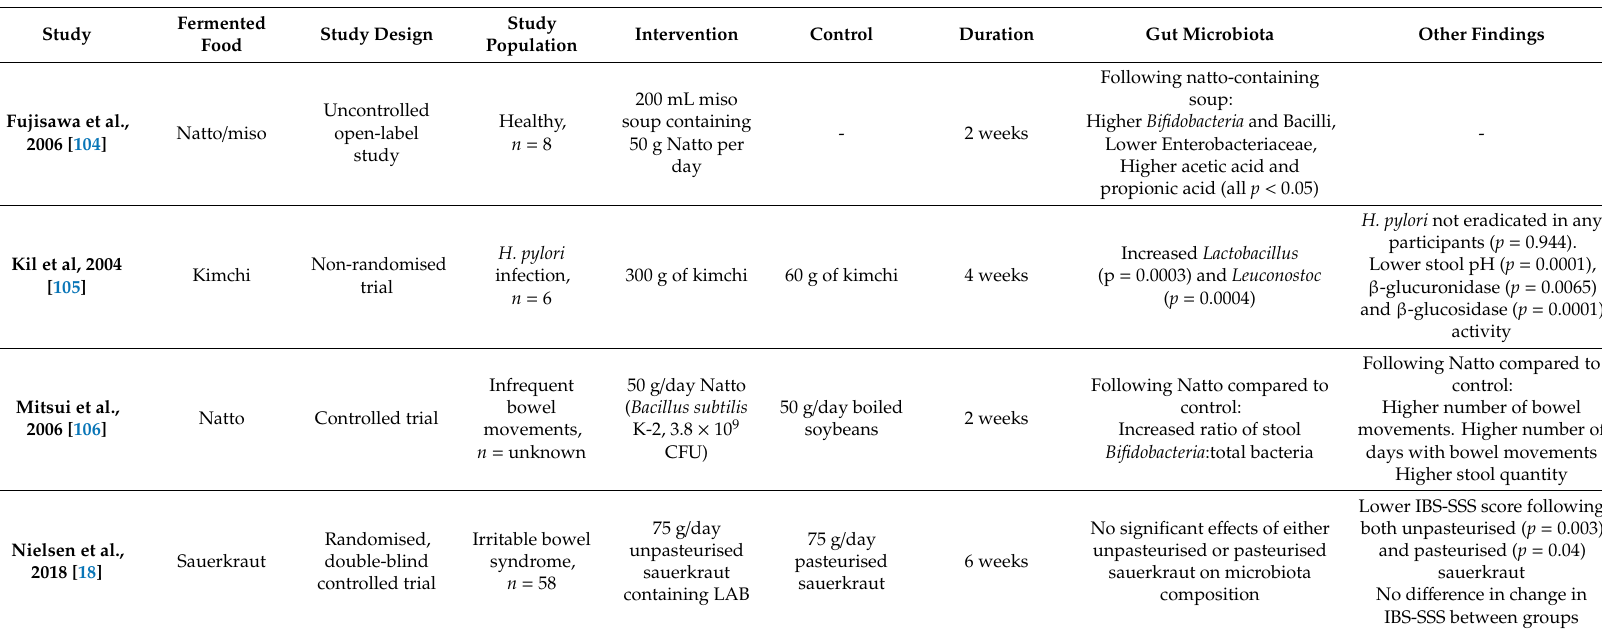
Table 3. Summary of interventions studies investigating the impact of sauerkraut, soy products and kimchi in gastrointestinal health and